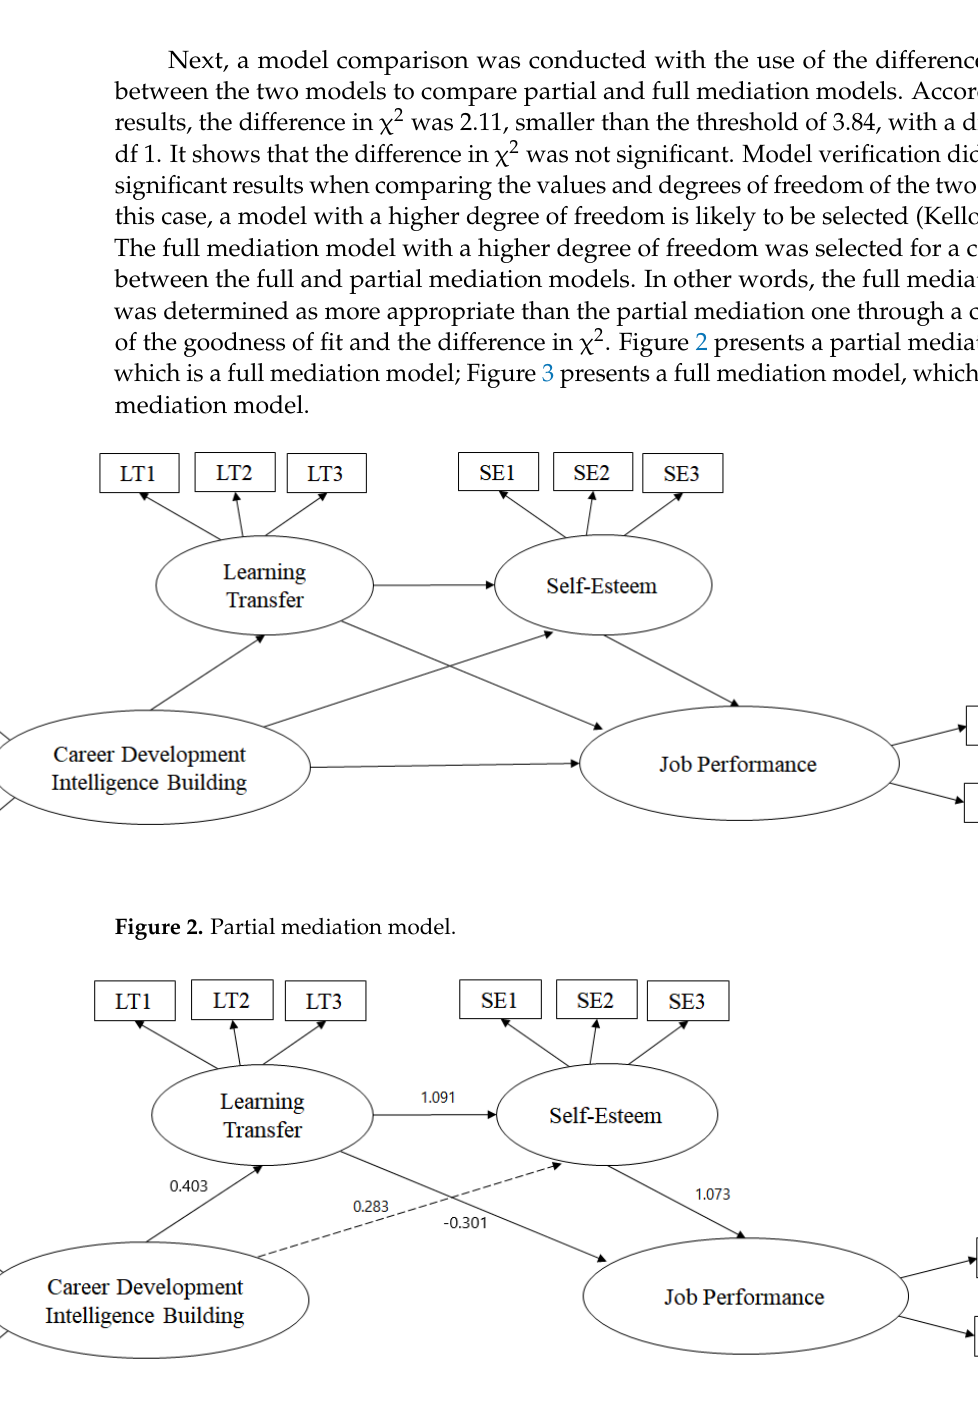
Table 4. Goodness-of-fit Indexes for the Structural Equation Model .